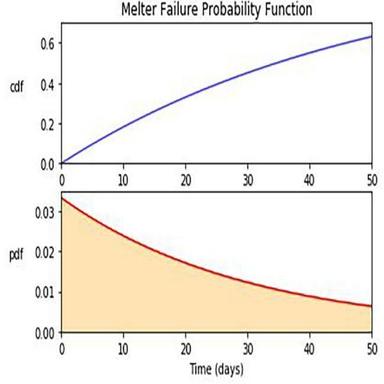
The cumulative density function for melter failure is shown above. As the operation time increases, the equipment is more likely to fail.